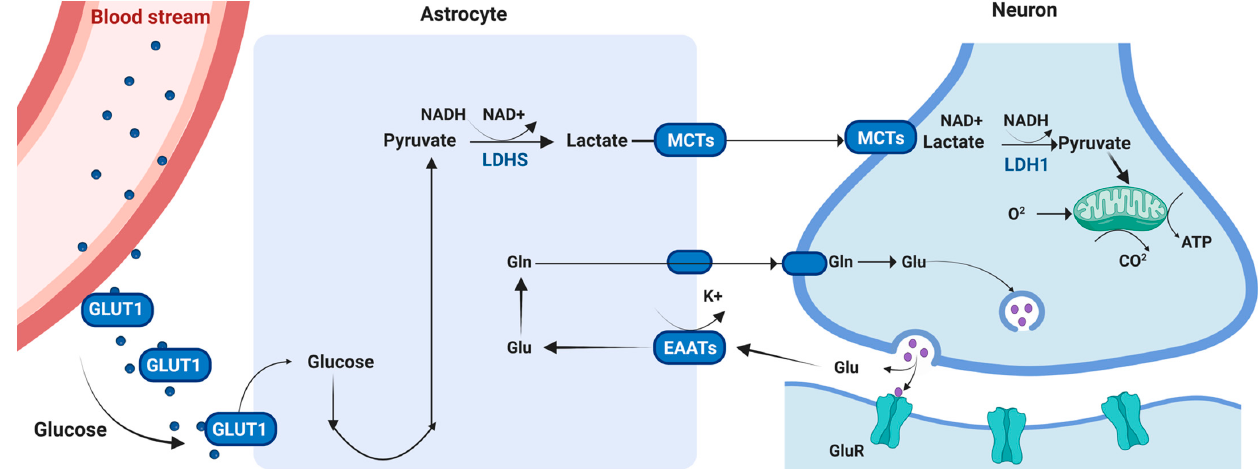
Figure 3. Astrocyte–Neuron Lactate Shuttle (ANLS) Formation. The ANLS is formed during an increase in neuronal energy demand. Astrocytes sense an increase in the glutamatergic excitatory pathway in the neuron and trigger glycolysis by up-taking glucose from the blood stream and con- verting it into lactate. Lactate is then transported to the neuron through MCTs in which is converted back into pyruvate and then shuttled into the mitochondria as a source of additional energy. Ab-